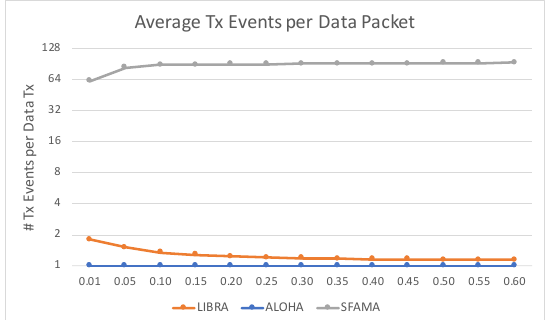
Figure 11. Average number of Tx events per data packet.